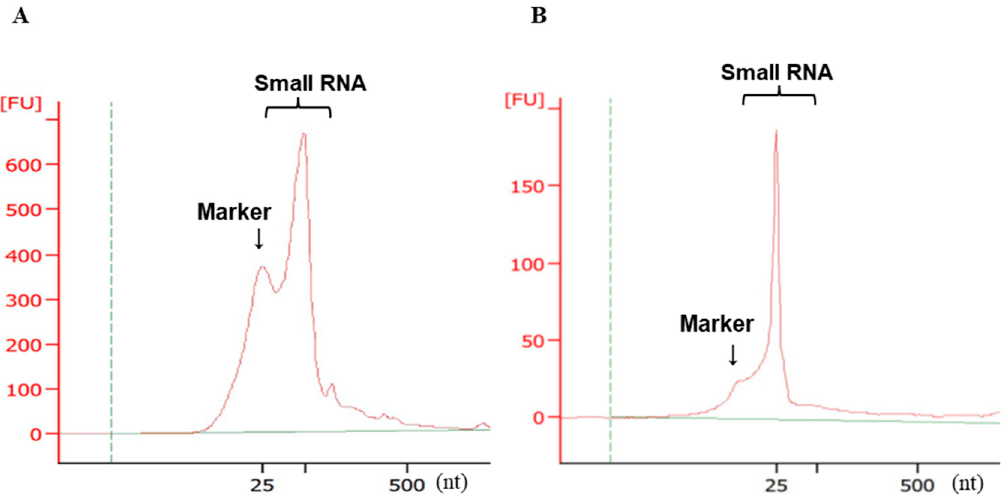
Figure 3. Representative images of the densitometry profiles of miRNAs isolated from exosomes. ( A ) MCAS, ( B ) HAC-2 cells. The vertical and horizontal axes indicate fluorescence units (FU) and RNA length in nucleotides (nt). The peak for small RNAs (25–200 nt) corresponds to exosomal miRNAs; marker indicates the internal standard (25